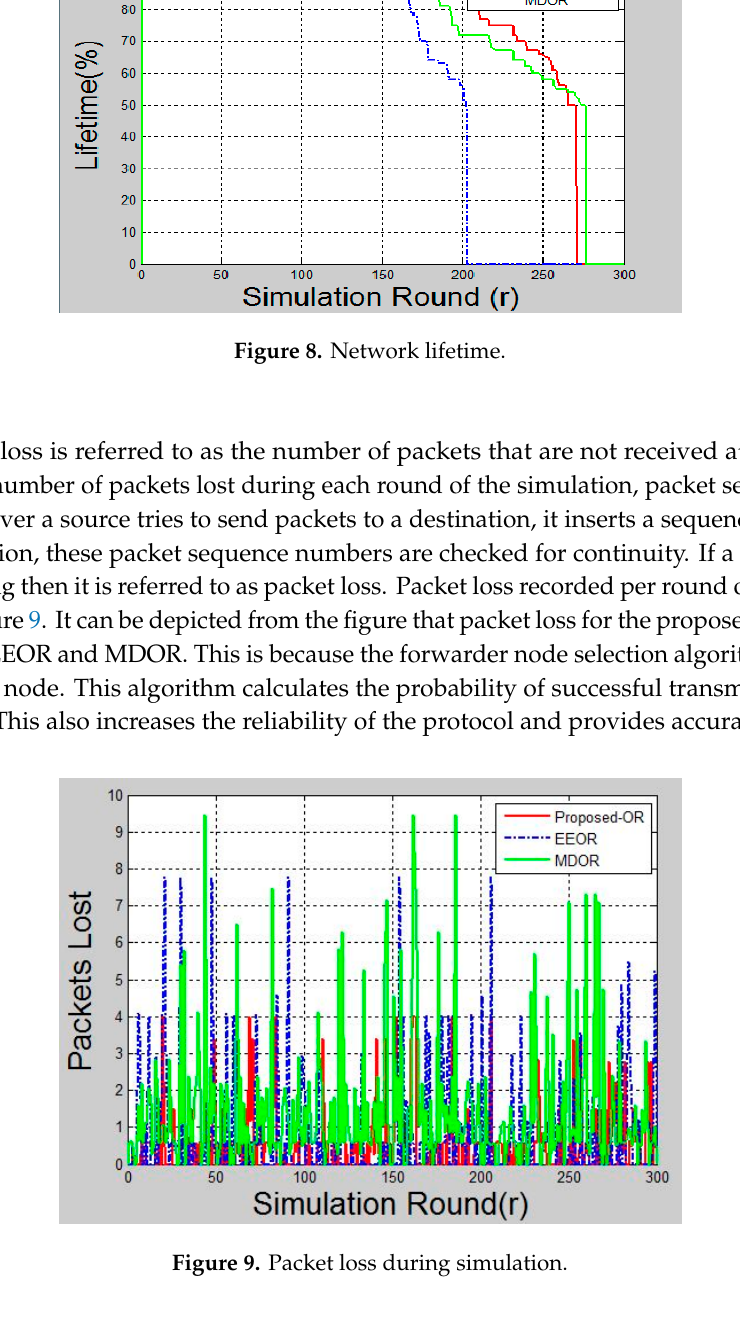
Figure 8 represents the percentage of lifetime remaining after each round of simulation. Proposed OR protocol has a good network lifetime due to the lower energy consumption in the network.